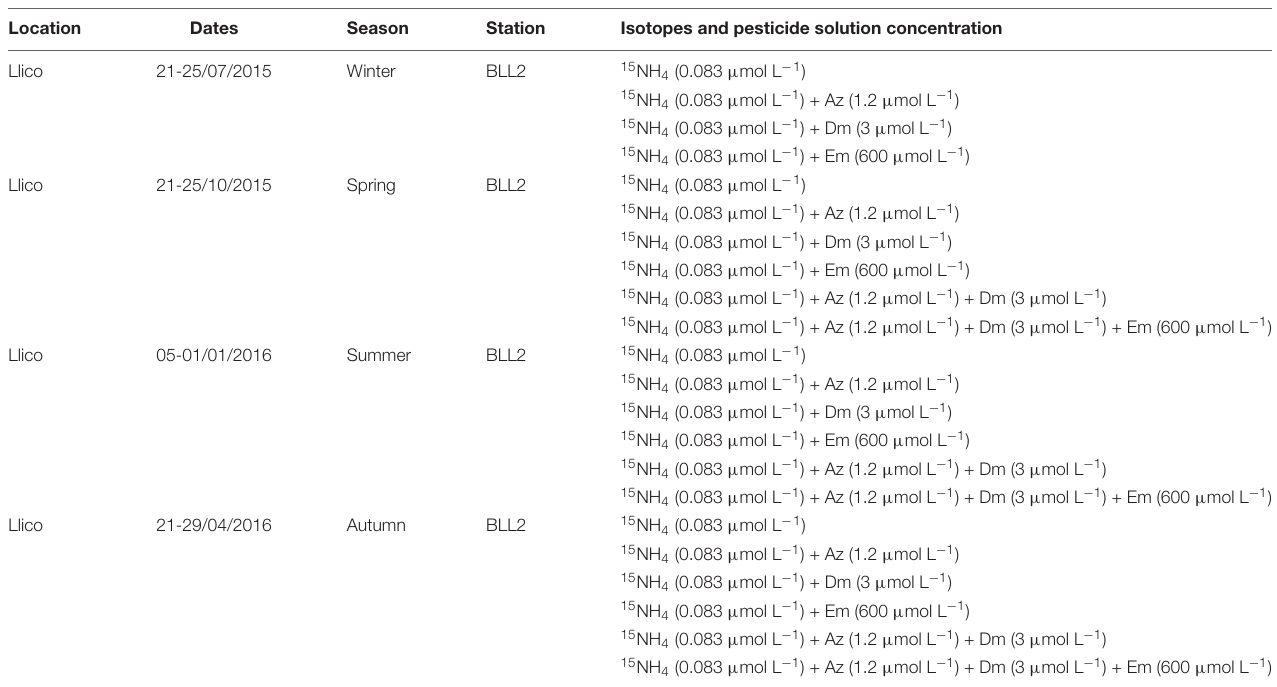
TABLE 3 | Summary of on-deck ammonium uptake incubations in Llico